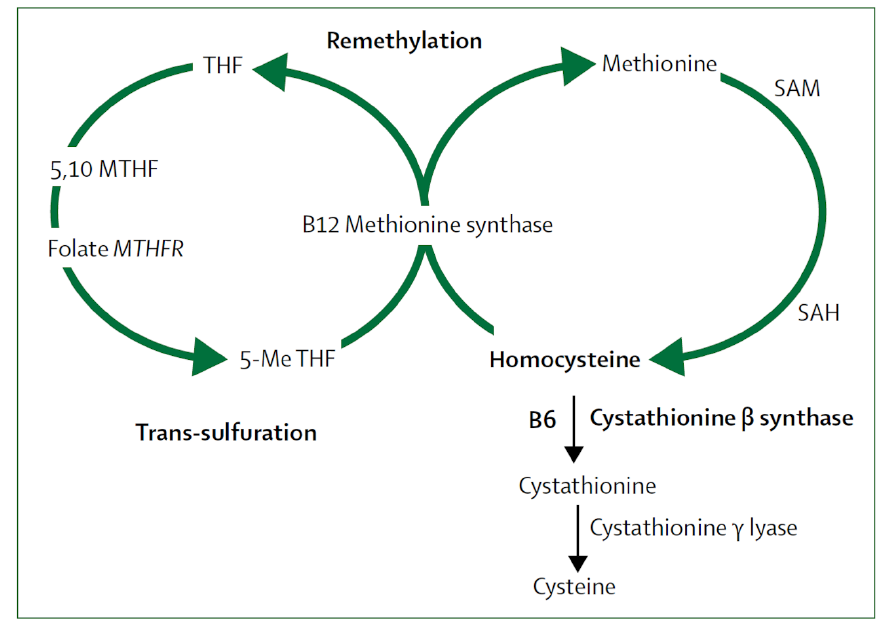
Figure 4. Homocysteine metabolism. B12 = cobalamin. B6 = pyridoxine. MTH = methylenetetrahydrofolate. MTHFR = methylenetetrahydrofolate reductase. SAM = S-adenosylmethionine. SAH = S-adenosylhomocysteine. 5-Me THF = 5-methyl tetrahydrofolate.